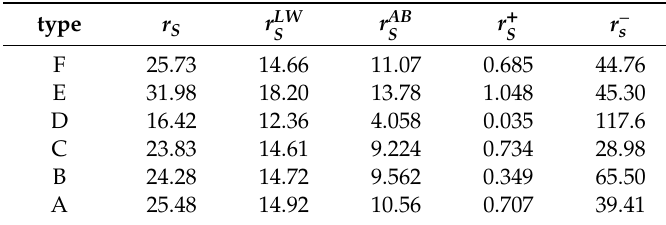
Table 10. Surface energy parameters of